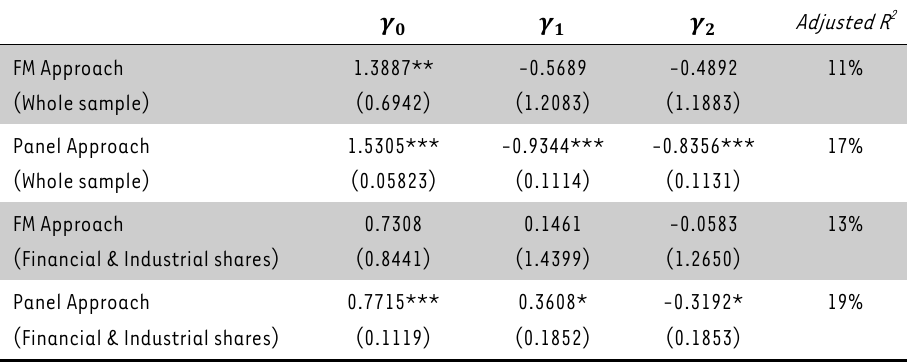
TABLE 3: Coefficient Estimates for the Conditional CAPM